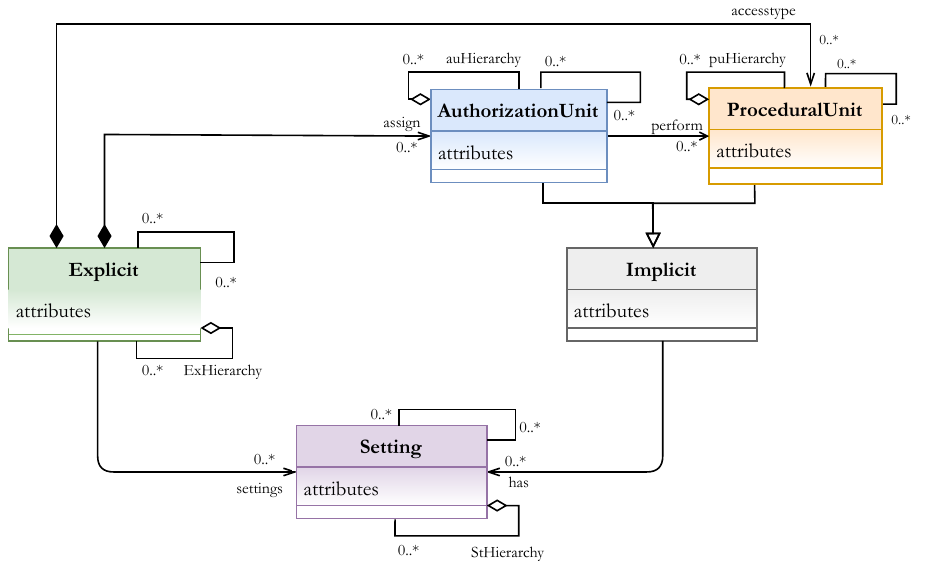
Figure 3. HEAD metamodel: the kernel